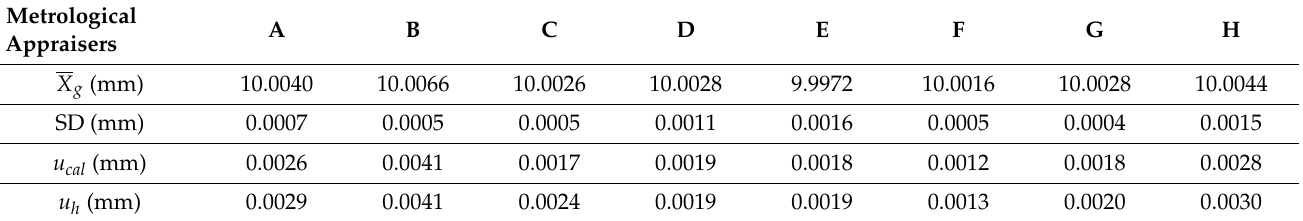
Table 2. Mean value X g and standard deviation SD measured during calibration, standard uncertainty of calibration u cal and average value of standard uncertainty of measured dimension d 2 u h